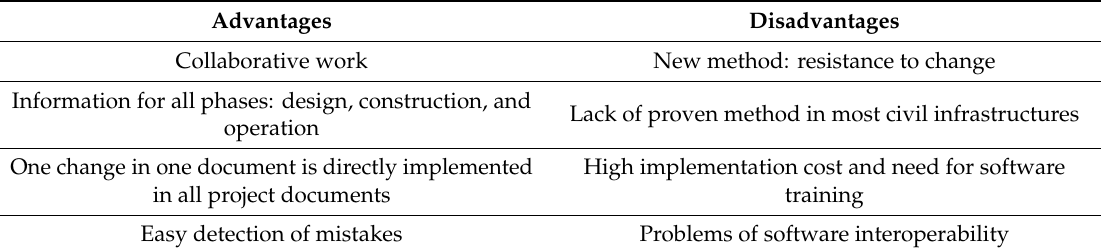
Figure 2. Proposal for the application of building information modeling (BIM) in the maintenance of infrastructures. Table 1. Advantages and disadvantages of BIM method in comparison to traditional